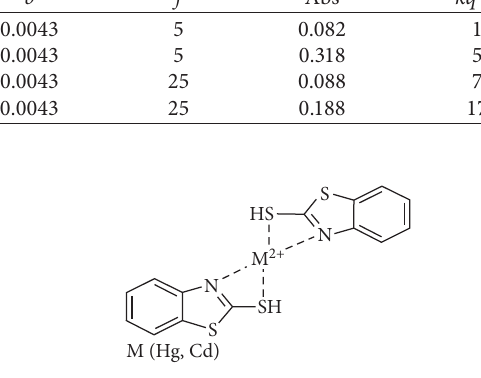
Figure 7: General formula of M-MBT complex ( M � Hg, Cd).